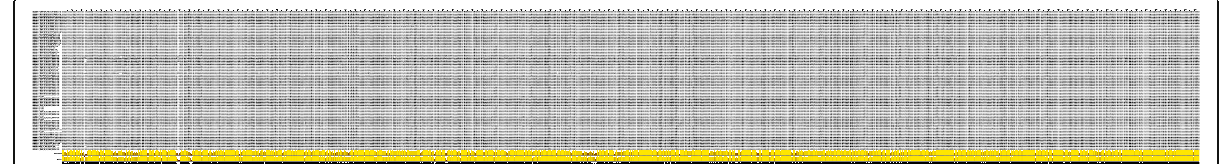
Fig. 3 Multiple sequence alignment of spike (S) protein of IBV visualized by Jalview 2.10.5. Yellow color bar and star sign indicate the full conservation . The brown region indicates the mismatched sequences among them. Black bars show the consensus logo sequence and yellow color indicates good quality